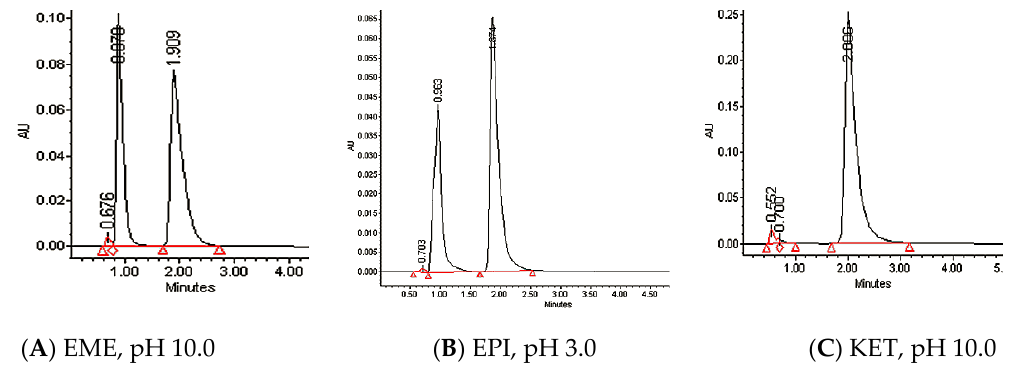
Figure 3. Chromatograms of ( A ) emedastine (EME), ( B ) epinastine (EPI), and ( C ) ketotifen (KET) after UV/Vis irradiation in buffer solutions.